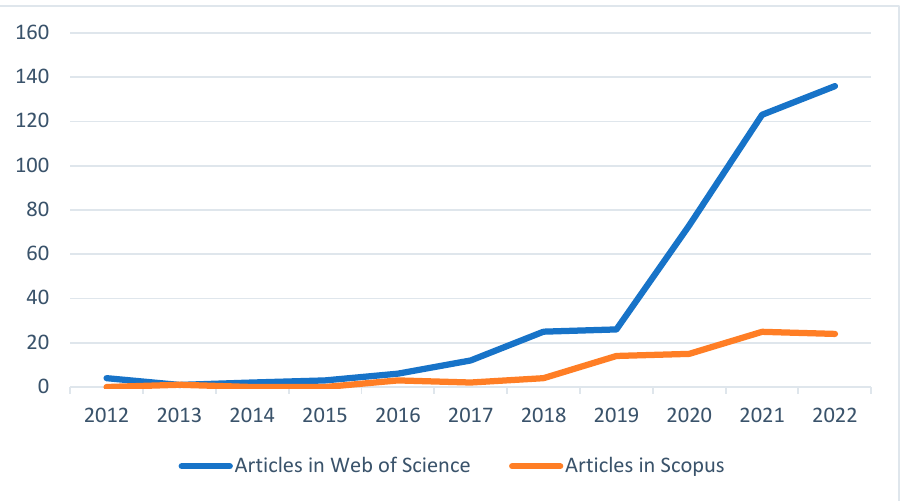
Figure 8. Evolution of the number of publications on the topic of digitalization in energy production, distribution, and consumption in the period 2012–2022 in the Web of Science and Scopus databases.